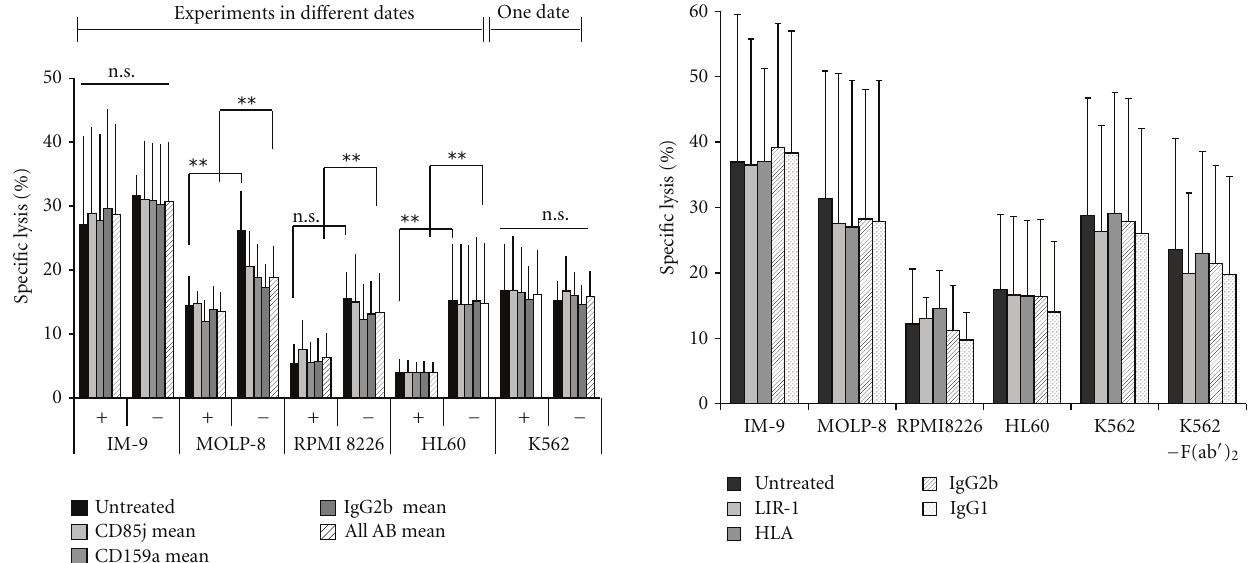
Figure 6: Use of F(ab (cid:3) ) 2 does not significantly influence cytotoxicity of NK-92 cells. Statistical analysis (ANOVA) reveals a seemingly protective e ff ect by F(ab (cid:3) ) 2 fragments against NK-92 mediated lysis. As influence of the type of antibody and the used concentration were excluded, experimental data were merged. Results were highly significant (untreated ± F(ab (cid:3) ) 2 /Ab use ± F(ab (cid:3) ) 2 ): IM-9 P = 0 . 317/ P = 0 . 211; MOLP-8 P = 0 . 017/ P = 0 . 002; RPMI8226 P = 0 . 052/ P < 0 . 001; HL60 P = 0 . 009/ P < 0 . 001; K562 P = 0 . 692/ P = 0 . 771). The same settings were used throughout all experiments. In the experimental row, K652 tests were performed at the same day and within the same panel. For all other target cells, tests including F(ab (cid:3) ) 2 were performed first and were followed by those without additional treatment 1 week later. Though IM-9 renders more susceptible to lysis to a nonsignificant degree, time is the factor most likely to be taken into account, for targets incubated with “untreated” NK cells showed the same changes in sensitivity towards lysis.